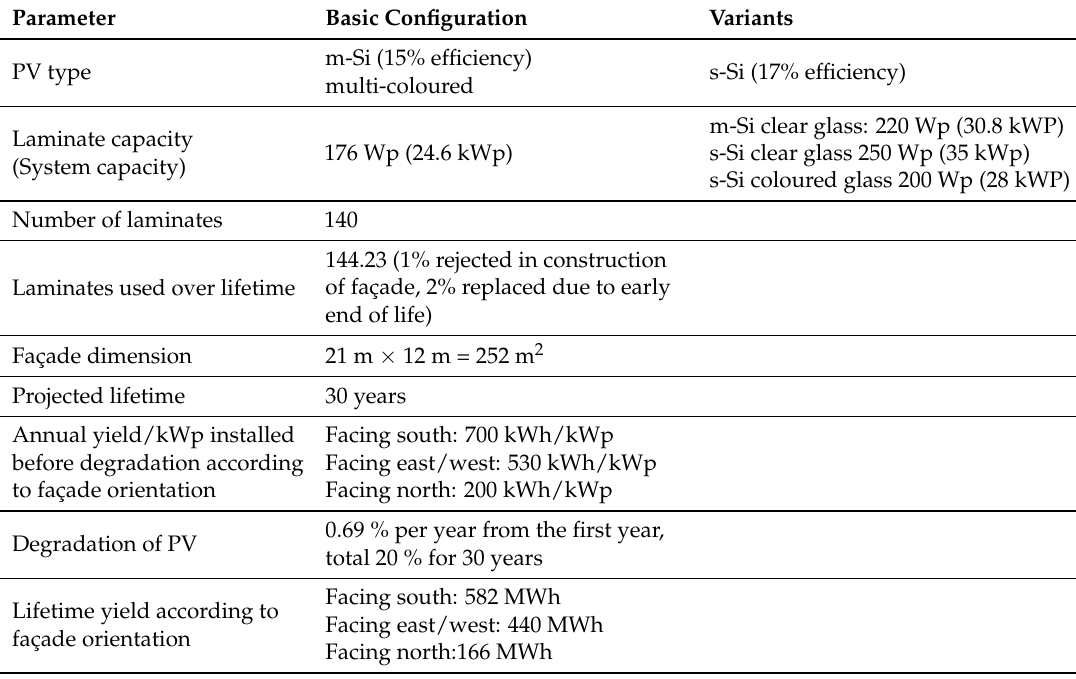
Table 3. Façade installation considered in this study as use case for photovoltaic (PV)